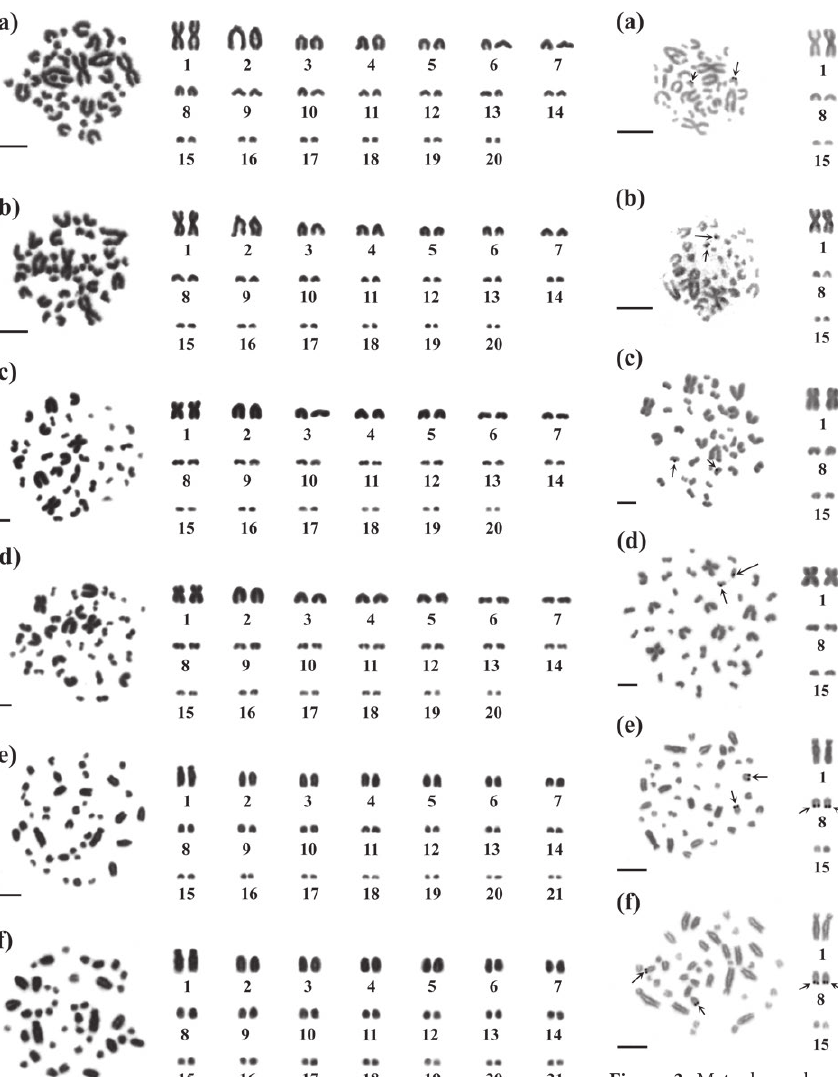
Figure 3. Metaphase chromosome plates and karyotypes using Ag- NOR staining of male (a) and female (b) D. hangseesom (2n=40); male (c) and female (d) D. siamensis (2n=40); and male (e) and female (f) D. melanostictus (2n=42). Arrows indicate nucleolar organizer regions (NORs) and scale bars indicate 10